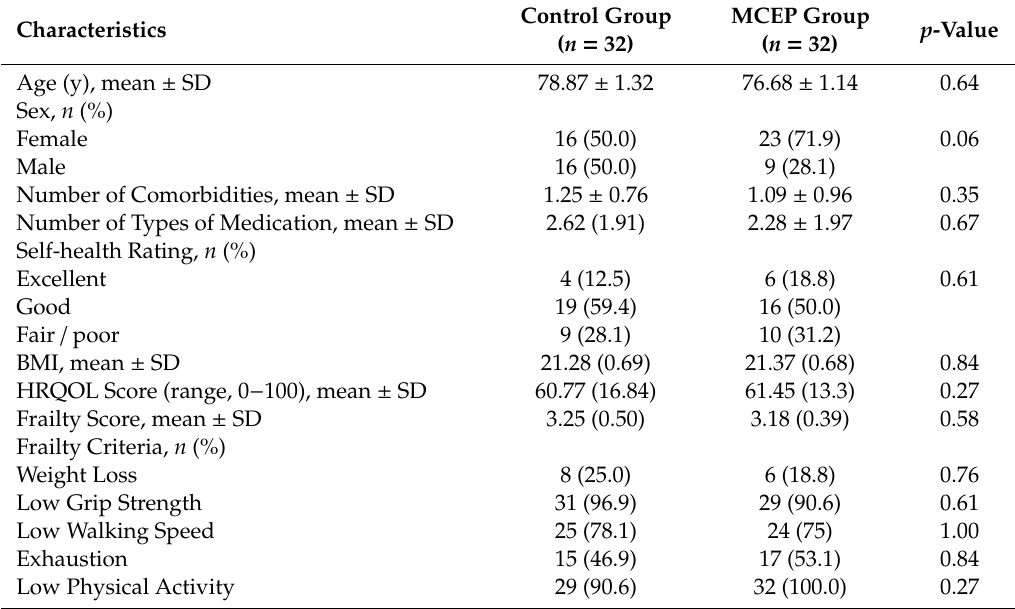
Table 2. Baseline characteristics of